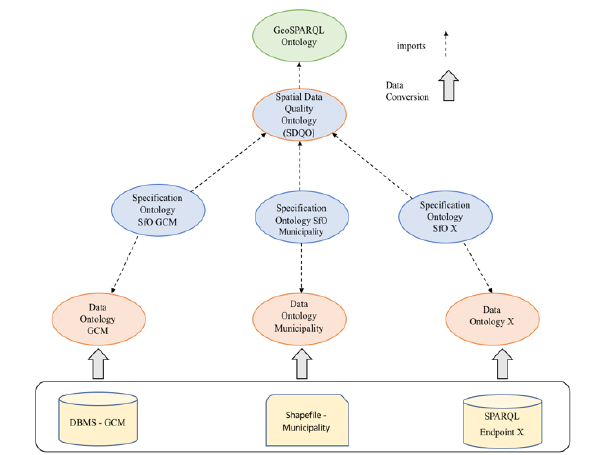
Figure 2. Ontologies and their